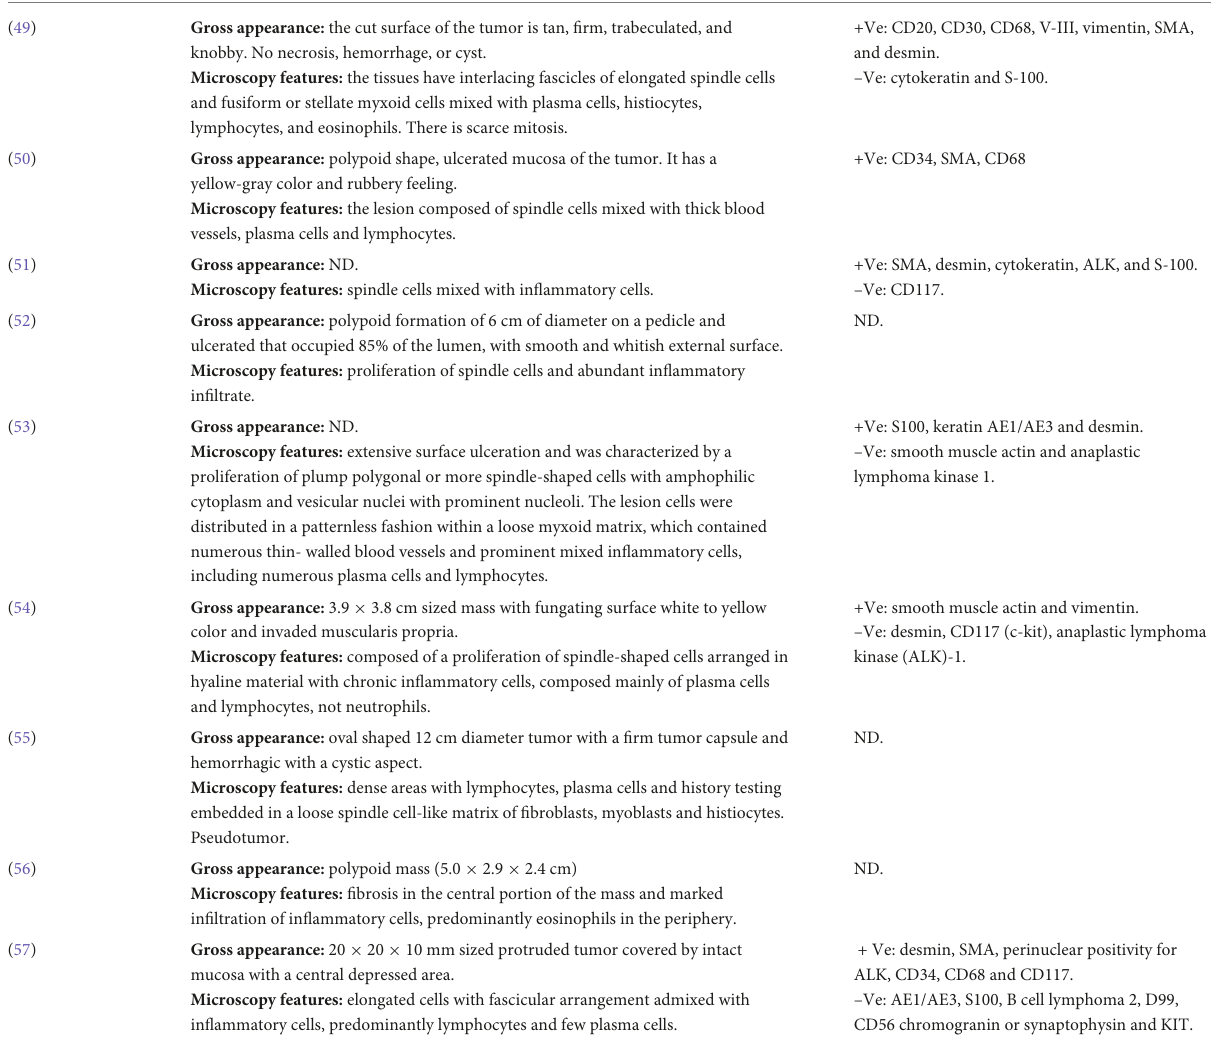
TABLE 6 Pathological features of the reported cases of inflammatory myofibroblastic tumor of the